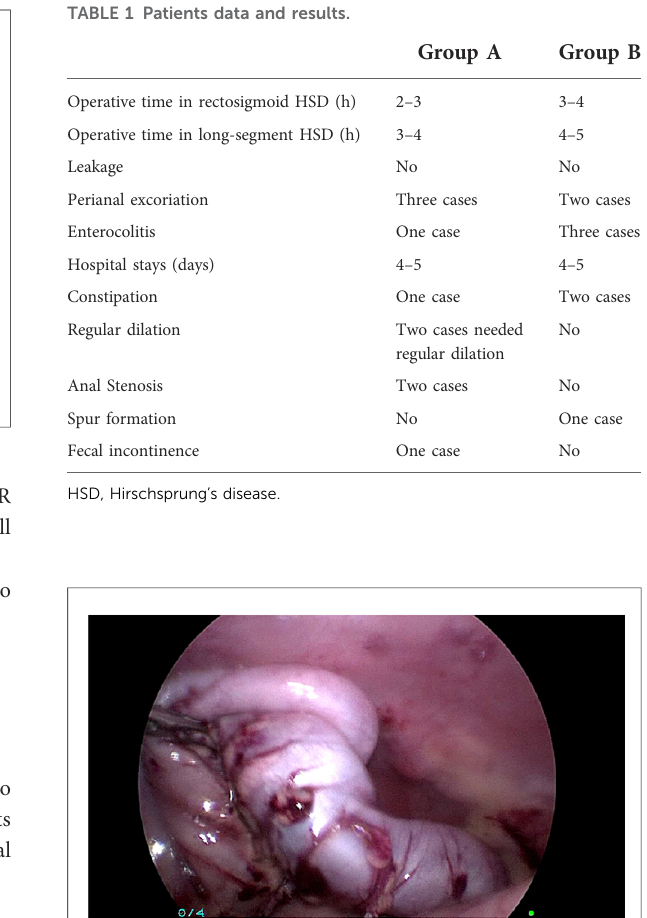
FIGURE 8 Transitional zone identi fi cation.